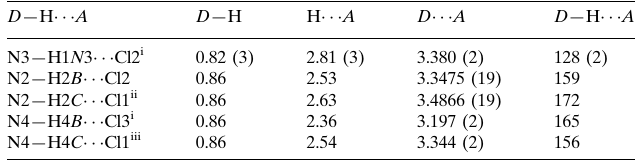
Hydrogen-bond geometry (A˚ , (cid:2)